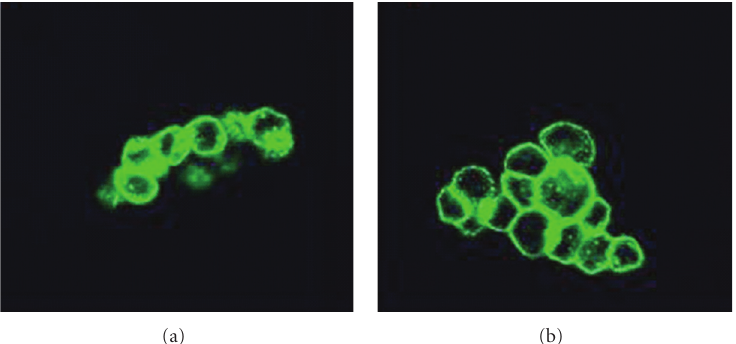
Figure 2: Confocal microscopy showing the interaction of (a) Bryothamnion seaforthii lectin, BSL, and (b) Bryothamnion triquetrum lectin, BTL PITC, labeled (at 4 ◦ C for 1 hour) with EB3 colon carcinoma cells variant. In this assay lectins were used at 10 μ g/mL. In each case the lectin uptake was weakly visualized.